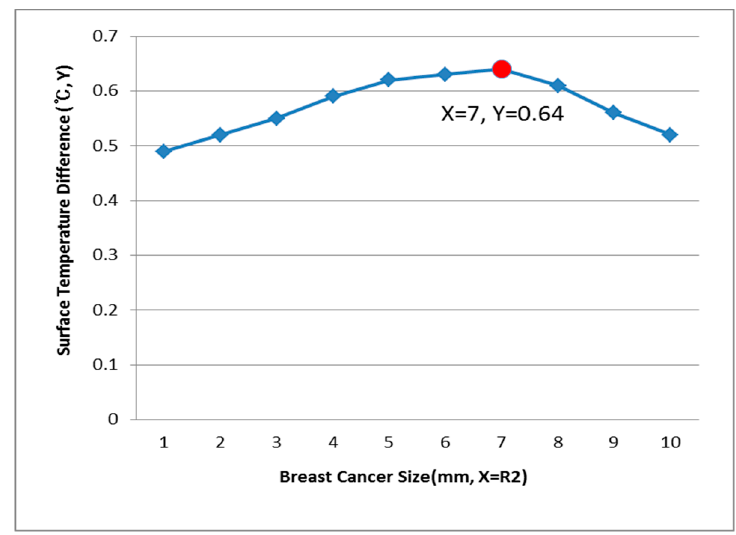
Figure 13. Surface temperature difference for an R1 of 70 mm (X = 10, Y = 10).